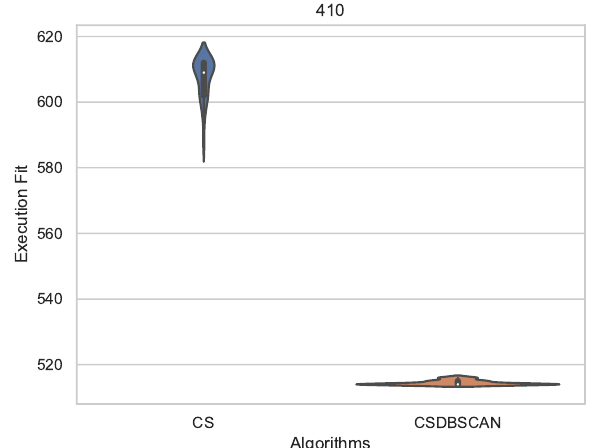
Figure 4. Instance 4.10 distribution.